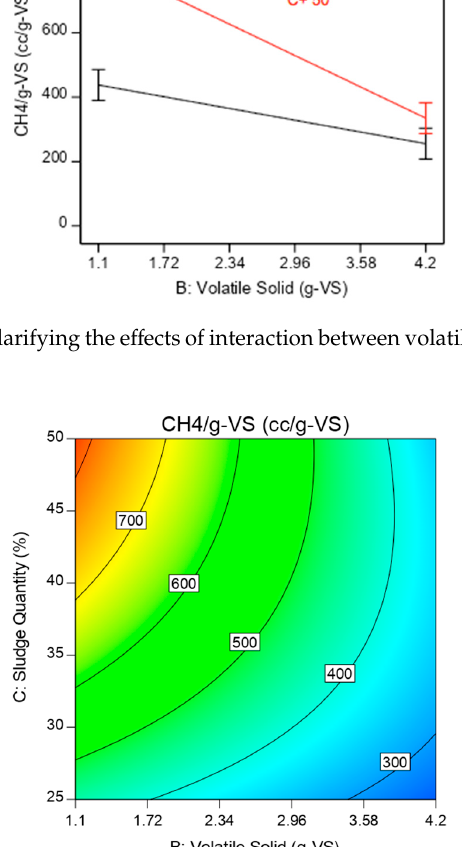
Figure 18. Contour plot showing the effect of volatile solid and sludge quantity on the CH 4 g –1 -VS% at a temperature of 37 °C.